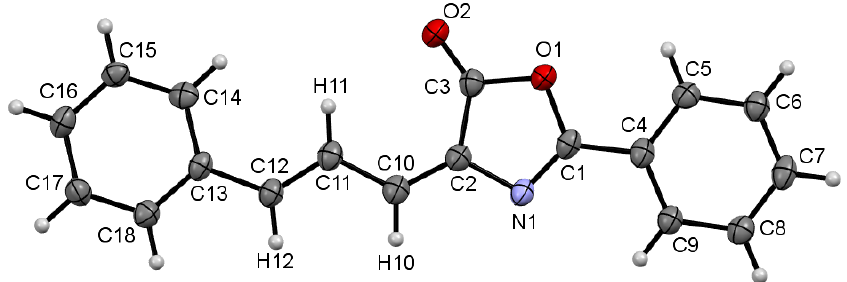
Figure 4. ORTEP drawing of oxazolone 1a showing the minor isomer with EE -configuration. Thermal ellipsoids are drawn with 50% probability.